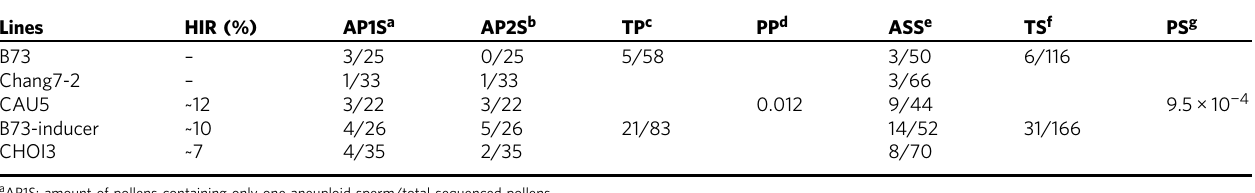
Table 1 Aneuploidy frequency of single pollen/sperm sequenced in this study